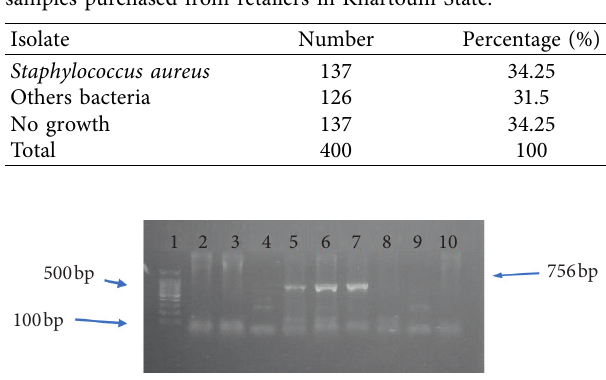
Figure 1: PCR amplification of 16S rRNA gene of S . aureus on 2% agarose gel electrophoresis. Lane 1 DNA ladder, MW 100–1500bp fragments. Lanes 5, 6, and 7 show a typical band size of 756bp corresponding to 16S rRNA of positive control isolates (isolates IDs 13, 55, and 63, respectively). Lanes 2, 3, 4, and 8 are the negative samples. Table 4: Distribution of mecA and enterotoxin genes among Staphylococcus aureus isolates.